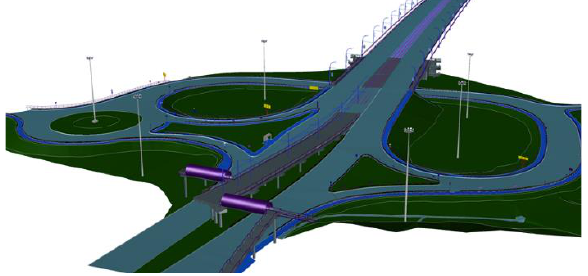
Figure 1 . 3D model of the highway for design by TLS data.